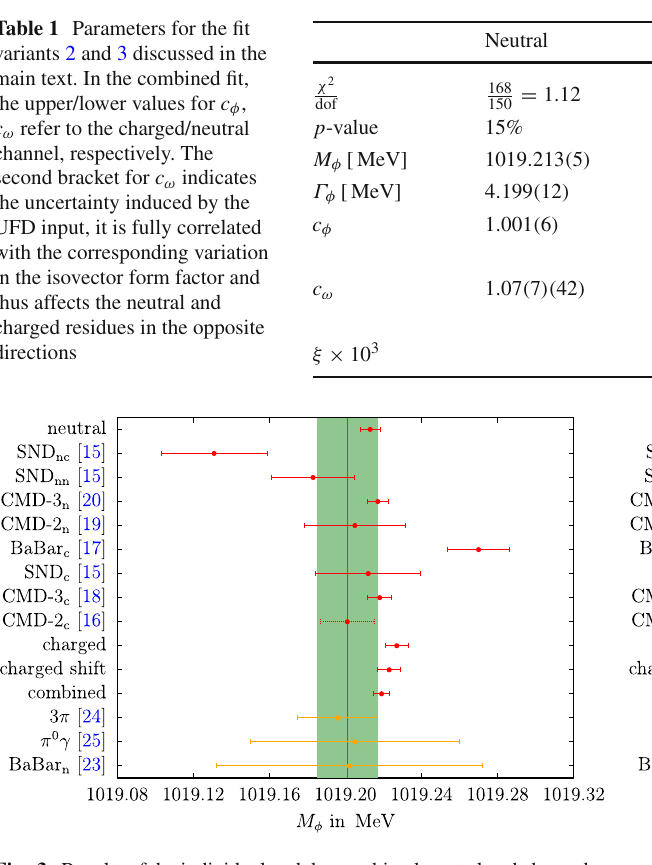
corresponds to the PDG mass average [26] shifted by the prescription from Ref. [25] to remove the VP effect. In orange the results for the e + e − → 3 π and e + e − → π 0 γ channels are given, as is the result for the neutral channel from BaBar